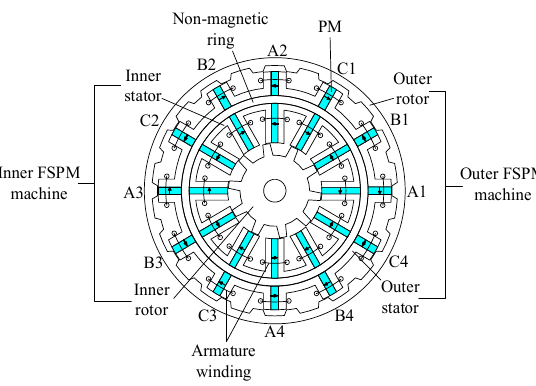
Figure 2. Topology of the proposed CADMP ‐ FSPM machine (inner: 12/10, outer: 12/22).